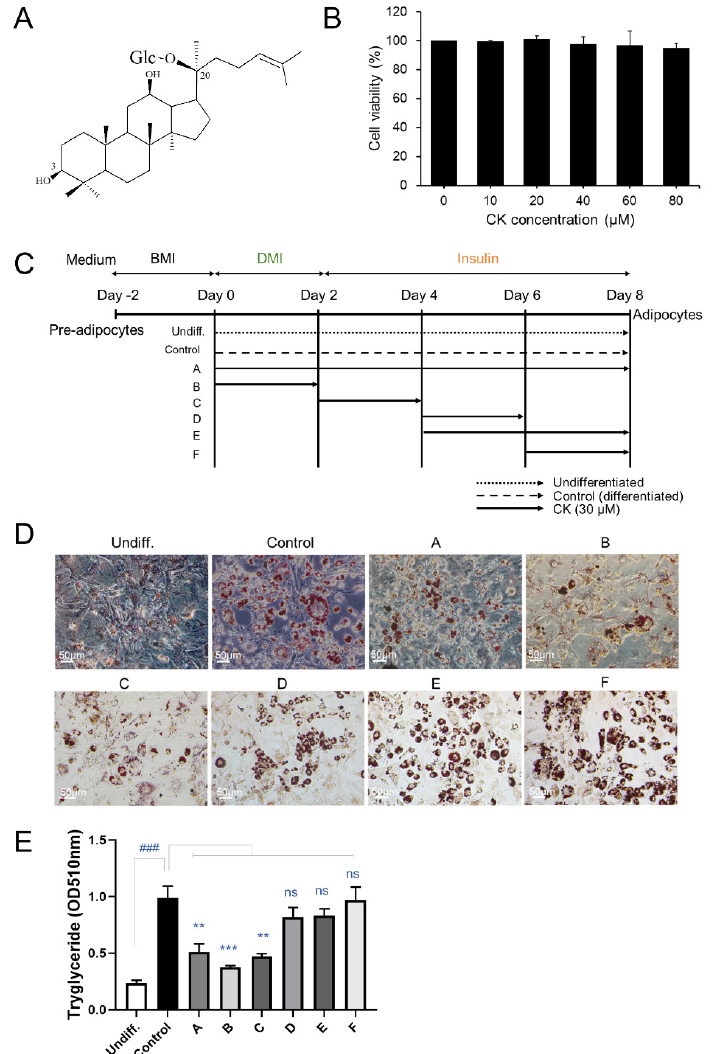
Figure 1. Effect of CK on cell proliferation and lipid accumulation in 3T3-L1 cells. ( A ) Chemical structure of compound K (CK). ( B ) 3T3-L1 pre-adipocytes were treated with CK at various concentrations (1, 10, 20, 40, 60, and 80 μ M) for 48 h. ( C ) Schematic diagram of various CK treatment periods during adipocyte differentiation. ( D ) 3T3-L1 cells were stimulated with differentiation medium (DMI) and treated with 30 μ M of CK at the indicated adipogenesis stages. After 8 days of differentiation, cells were stained with Oil Red O staining. ( E ) Stained Oil Red O was eluted with isopropanol, and absorbance was measured at 510 nm. Three independent experiments were performed, and the results were expressed as mean ± SEM. ### : p < 0.01, significant difference between DMI group and undifferentiated group; **: p < 0.01 and ***: p < 0.001, significant difference between DMI group and DMI + CK treatment group. The results were considered not significant (ns) when p > 0.05. We performed qRT-PCR, Western blot (WB), and immunocytochemistry (ICC) anal- yses to investigate the inhibitory effect of CK on adipogenic gene expression in mature 3T3-L1 cells. The differentiation of pre-adipocytes into mature adipocytes is regulated by transcription factors and genes including PPAR- γ , C/EBP β , C/EBP α , and FABP4 [16]. While we found that mRNA expression of Ppar- γ , C/ebp α , Fabp4, and Srebp1c decreased